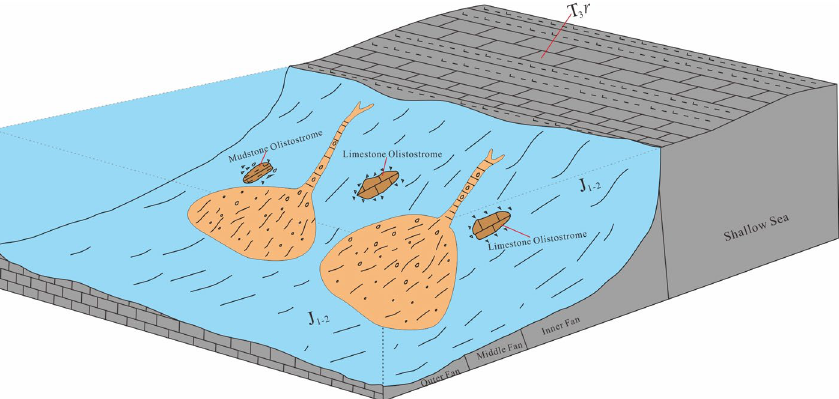
Figure 4. Model chart of the sedimentary facies of the Rigenco section in the northeastern Riganpeicuo area, South Qiangtang Basin,